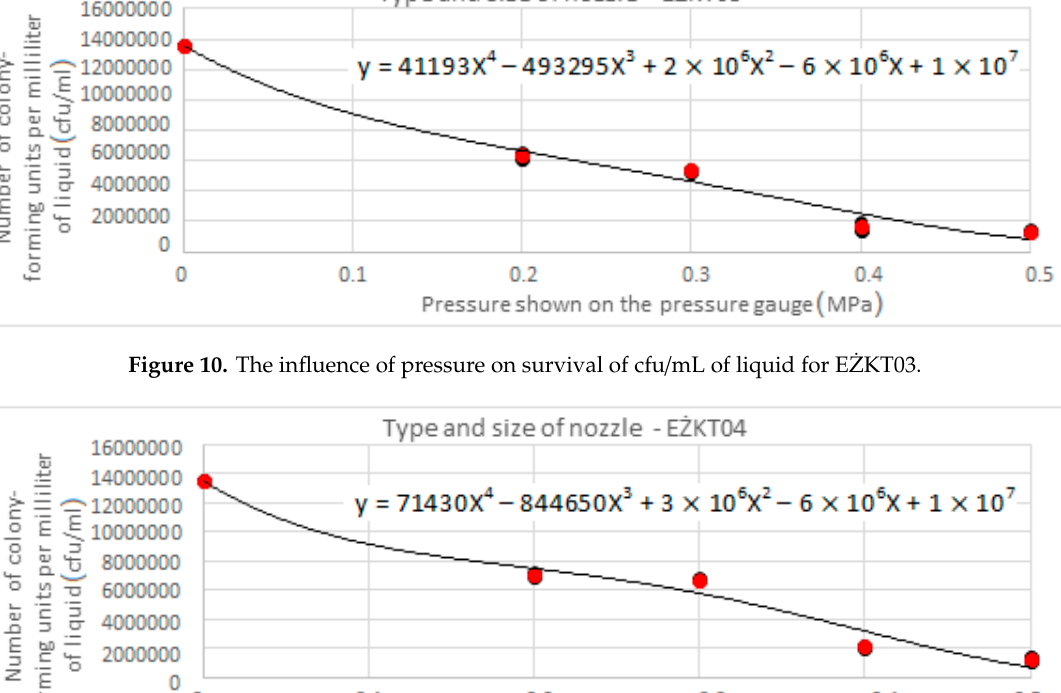
Figure 9. The influence of pressure on survival of cfu/mL of liquid for E Ż KT025.